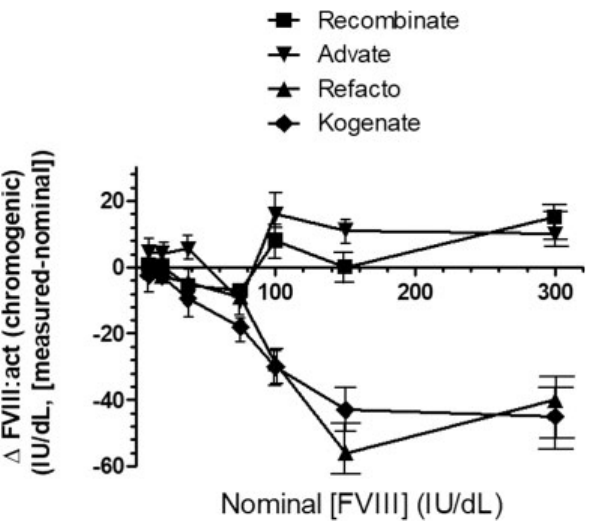
Fig. 5 Difference between the nominal FVIII concentration of the products used in this study (x-axis) and the corresponding concen- tration(y-axis) measured witha chromogenic assay.The valuesarethe mean of three different lots of each product. The vertical bars represent the standard errors from three different measurements from three different lots of the product. The intraassay standard error was 8 (cid:4) 3%.